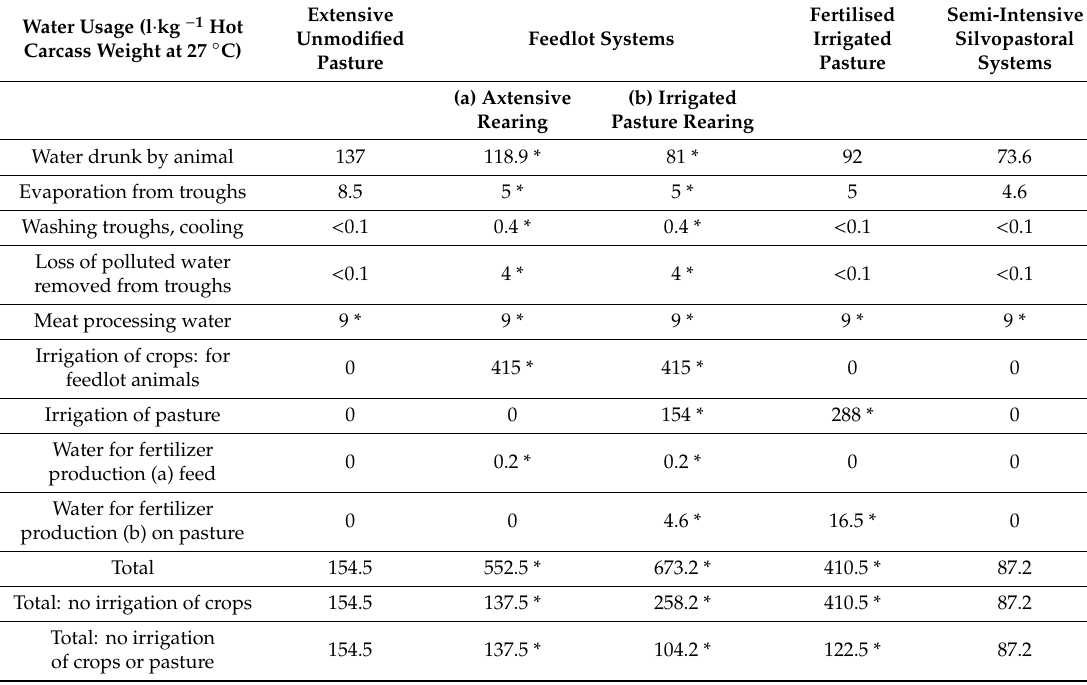
Table 2. Water usage in four beef production